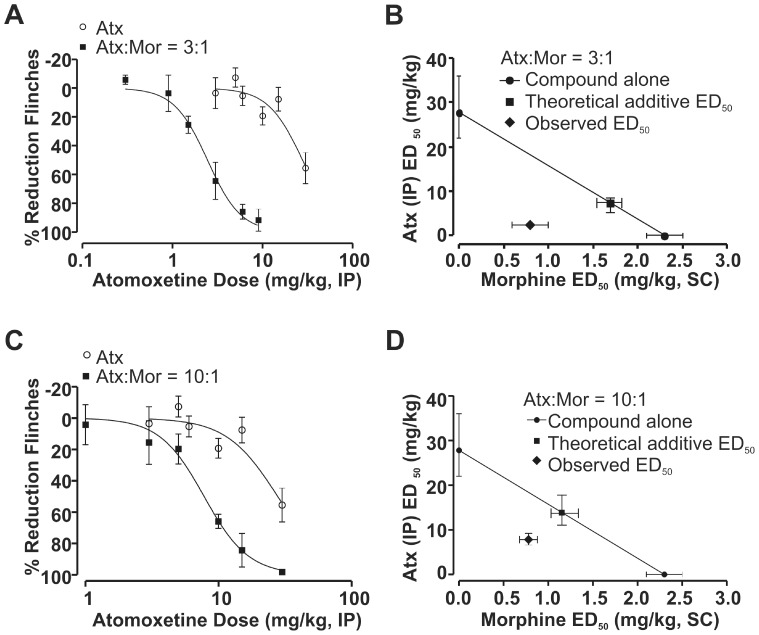
Atomoxetine exhibited antinociceptive synergy with morphine using a fixed-ratio design in the rat formalin model.(A) The dose-response curve of a fixed-ratio of 3 parts atomoxetine (Atx, IP) to 1 part morphine (Mor, SC) leftward shifted relative to the atomoxetine dose-response curve alone (n = 6–12). All data points are shown as mean ± SEM for each group and are expressed as percentage of controls. (B) An isobologram for the combined effects of atomoxetine and morphine in a fixed ratio combination 3∶1. The ED50 value for morphine is plotted on the abscissa, and the ED50 value for atomoxetine is plotted on the ordinate. The solid line represents the line of additivity and the isobol point (observed ED50 value) is located to the left and below the theoretical additive ED50 value (with non-overlapping 95% CI). (C) The dose-response curve of a fixed-ratio of concomitant administration of 10 part atomoxetine (IP) to 1 part morphine (SC) leftward shifted relative to the atomoxetine dose-response curve alone (n = 6–16). All data points are shown as mean ± SEM for each group and are expressed as percentage of controls. (D) An isobologram for the combined effects of atomoxetine and morphine in a fixed ratio combination 10∶1. The isobol point (observed ED50 value) is located to the left and below the theoretical additive ED50 value (without overlapping 95% CI).